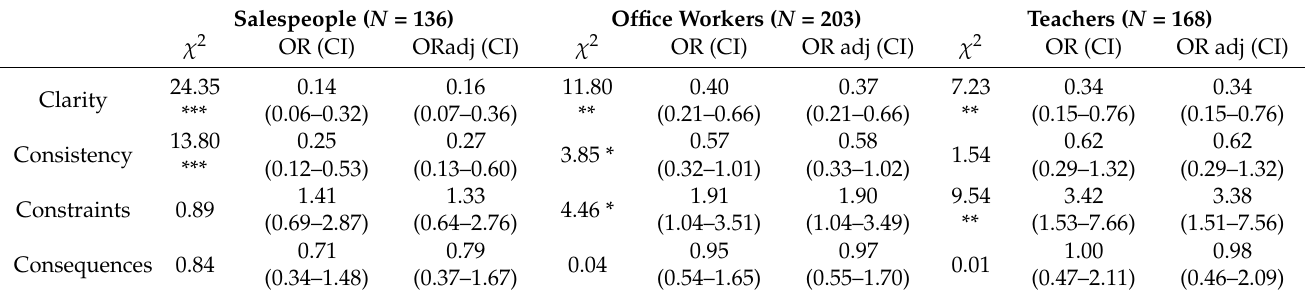
Table 2. Risk factor analysis: odds ratio and confidence